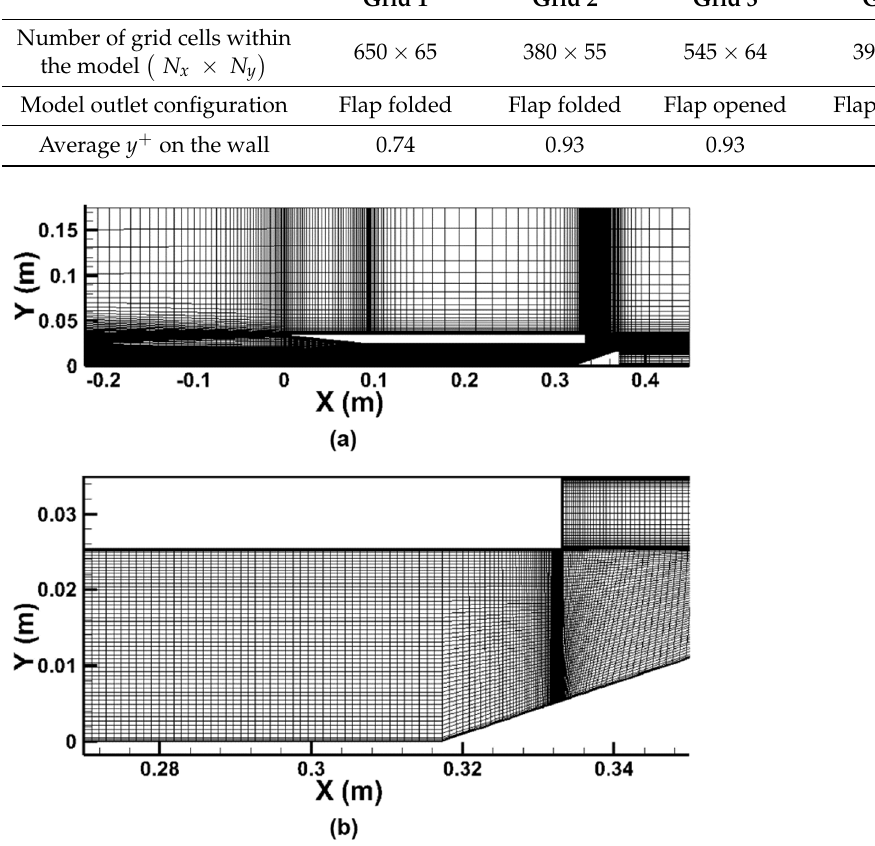
Table 1. Number of grid cells used in the grid independency test.